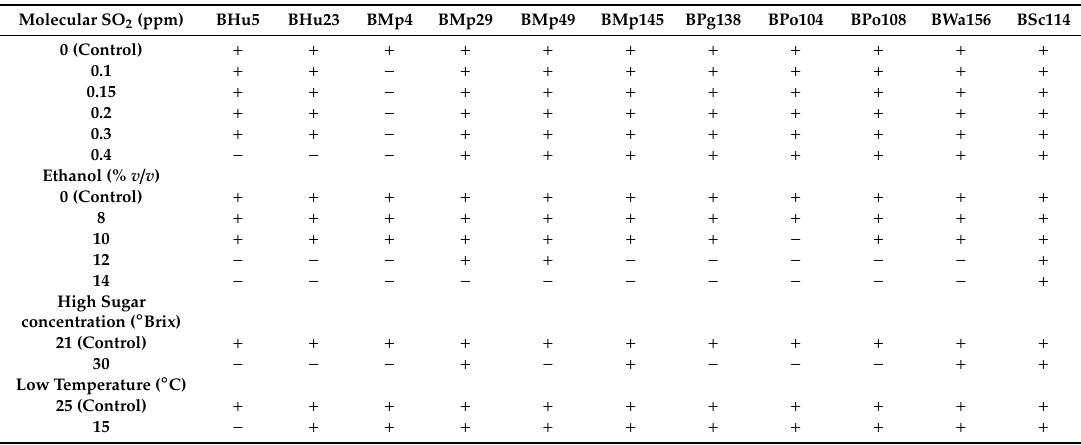
Table 3. Tolerance of individual strains to high sugar concentration and low temperature, and di ff erent concentrations of molecular SO 2 and